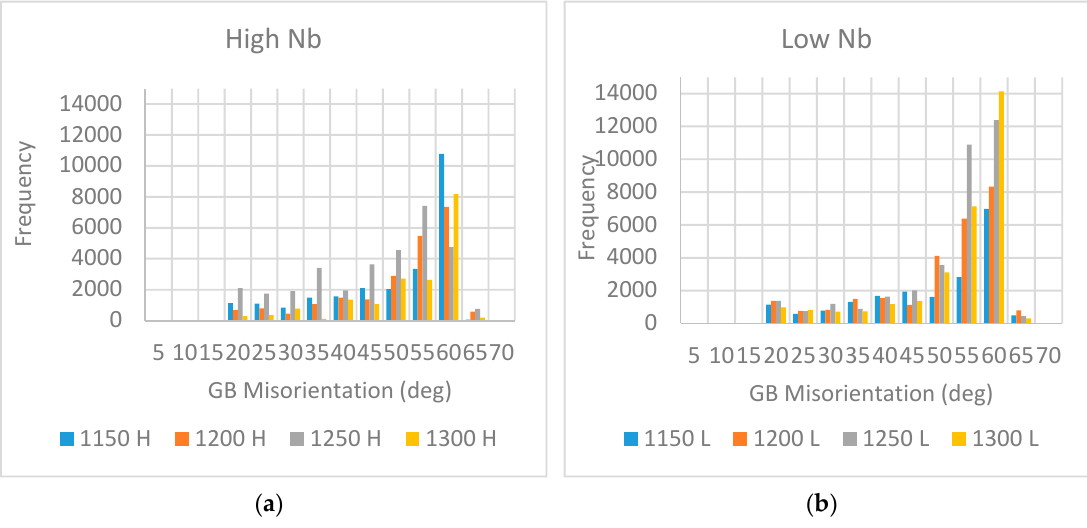
Figure 15. Distribution of GB misorientation for various temperatures on: ( a ) High-Nb steel and ( b ) low-Nb steel.